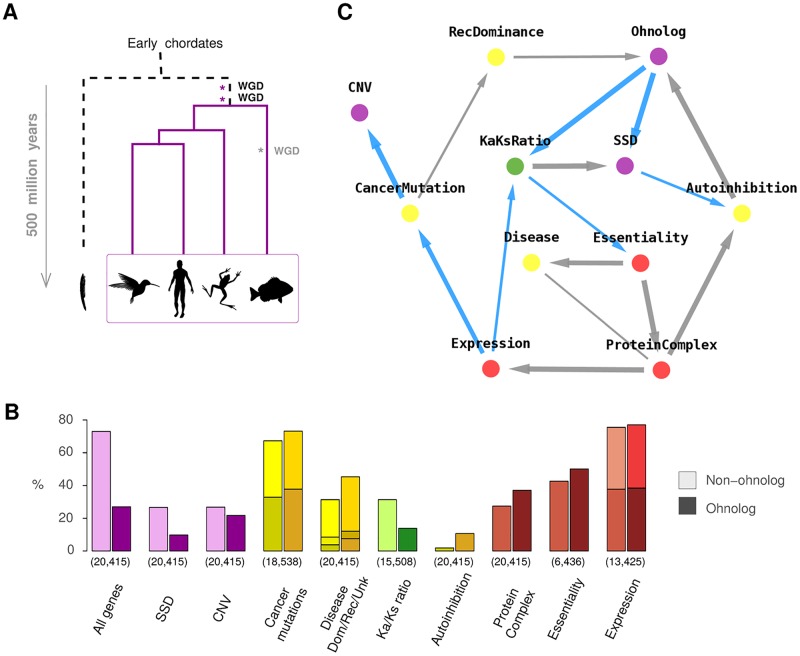
Network reconstruction at organismal and phylogenetic levels.(A) Two rounds of whole genome duplication (WGD) have led to the evolutionary radiation of vertebrates (and similarly with a third 300-MY-old WGD in teleost fish). (B) Biased distributions of genomic properties within ‘non-ohnolog’ and ‘ohnolog’ genes retained from WGDs in early vertebrates [45]. Numbers in brackets indicate the numbers of genes for which each property is identified, Materials and Methods and S1 Data. (C) Genomic property network of human genes, see main text. Graph predicted with miic R-package and visualized using cytoscape (blue edges correspond to repressions).